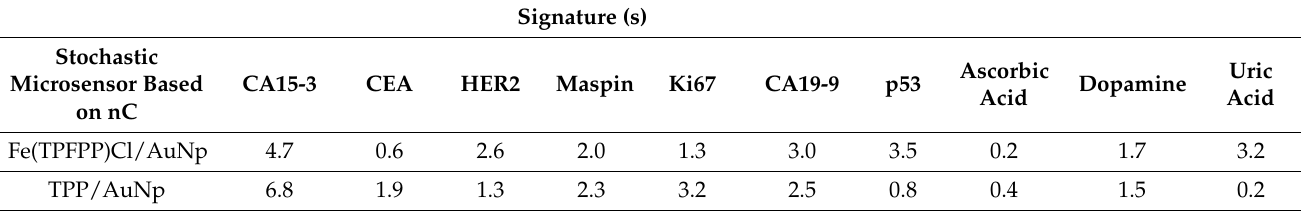
Table 2. Selectivity of the stochastic microsensors.